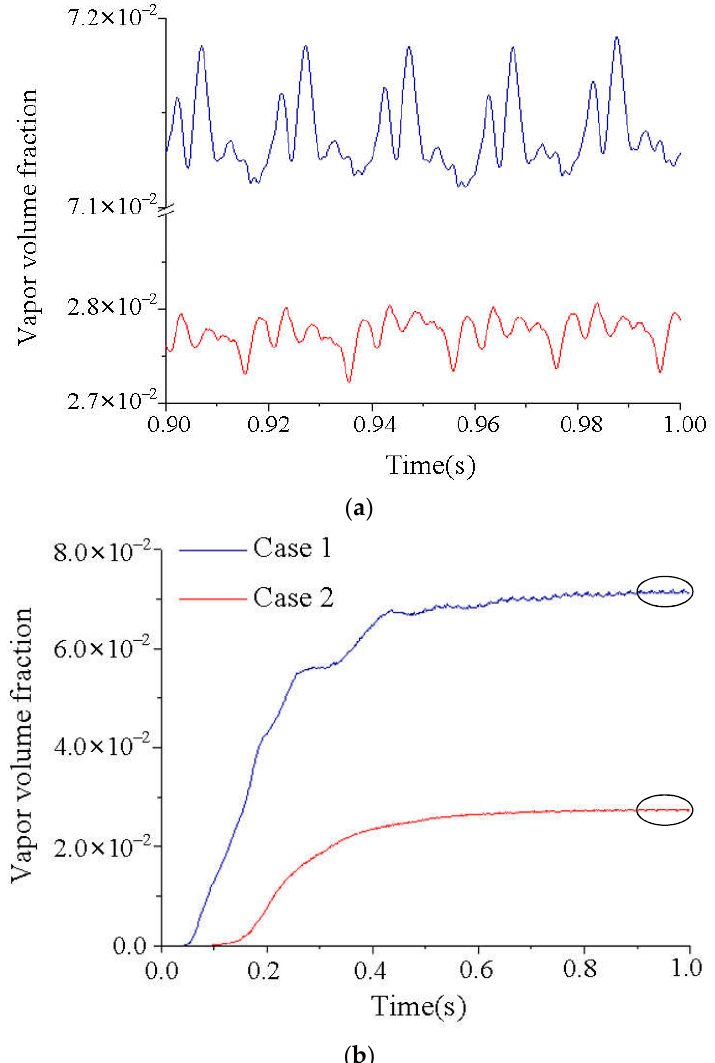
Figure 12. Time histories of the volume fraction of vapor in the impeller domain: ( a ) the enlarged view; ( b ) the focused view.